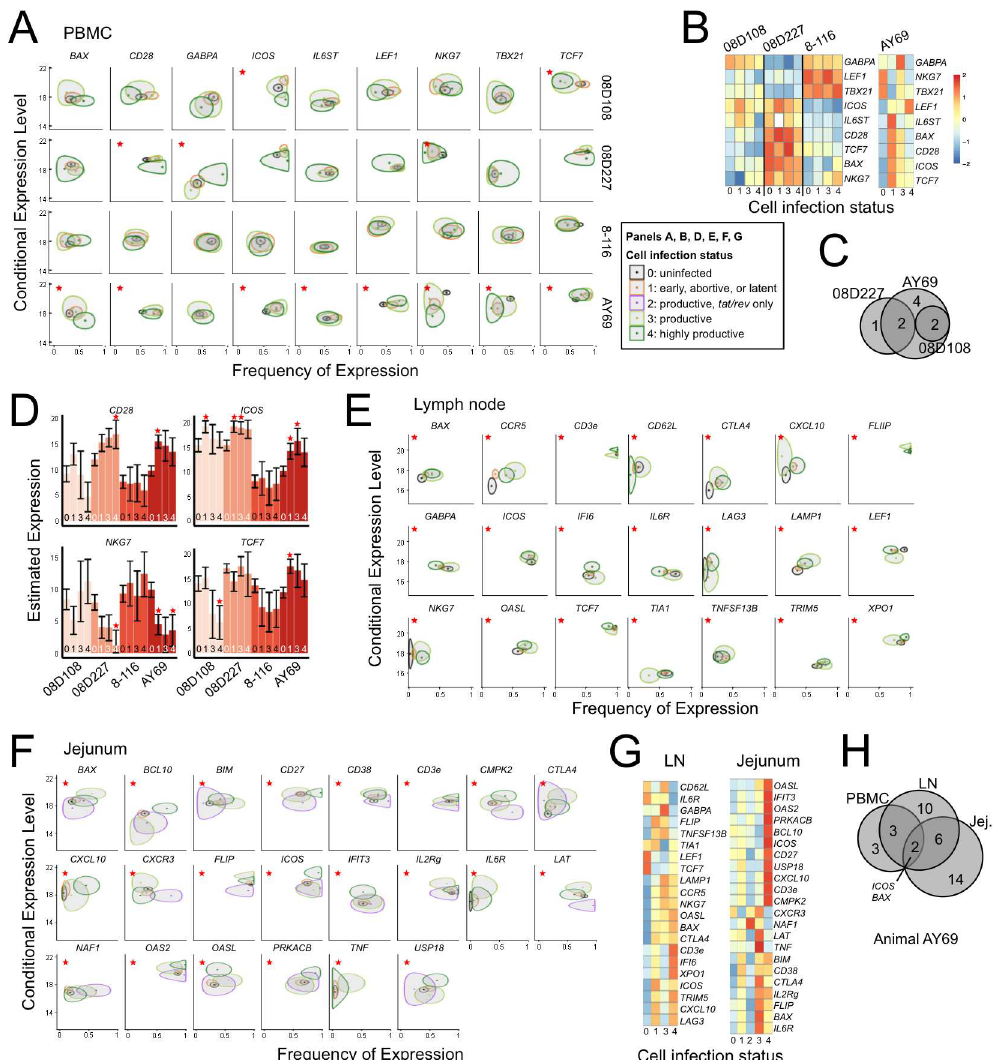
Fig 2. Differential host gene expression by in vivo SIV-infected T cells. (A) Genes showinga changein expressionlevel or proportionin singlecells from one or more infectionstates comparedto uninfectedcells in PBMC from one or more animals(n = 4). Significantchanges(FDR < 0.1) are indicated( * ). Plots displaythe MAST estimates of averagefrequency of expression (x-axis) andaverageexpression level in cells whena gene is expressed(y-axis) for eachgeneby cell infection state (ellipse).Boundariesreflect the 90% bivariateWald test confidenceinterval(Chi-square,2 degrees of freedom). Contourswith minimal or no overlapare more likely to be associatedwith a significantdifference. The numberof cells analyzedfrom each infection state is shownin S3 Table. ( B )PBMC Z-statistics (standardized modelcoefficients) show expression across animalsandinfectionstages by combining(using Stouffer’s method) the frequencyof expressionand continuousexpression. Expressionis mean centeredby row. ( C )Venn diagramof DE genesidentifiedby the hurdlelikelihoodratio test, common to PBMC from multipleanimals. ( D )Estimated averageexpression of four significantgenesfrom (A) by cellular infectionstate. For each animal, significant differences from uninfected cells (at the 10% level after multipletesting adjustment across 92 genestested) are marked with an asterisk. Unadjusted 95%confidenceboundsare shown for the expression level. ( E-G )Analysesof animalAY69 lymph nodeand jejunumas in (A-C). ( H )Venn diagramof DE genescommon across tissues withinanimalAY69. Two genescommonto all tissuesare indicated.Experiments wereperformed once for each specimenand all data is shown. post-translational mechanisms. Of note, despite similar tat/rev expression ( > 1000 copies/cell) observed in AY69 PBMC, lymph node, and jejunum, surface CD4 was unchanged on tat/rev +